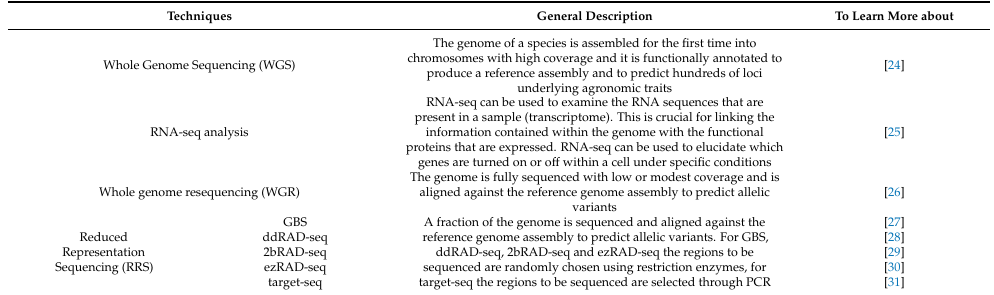
Table 1. Overview of the main genomics and transcriptomics techniques useful for breeding